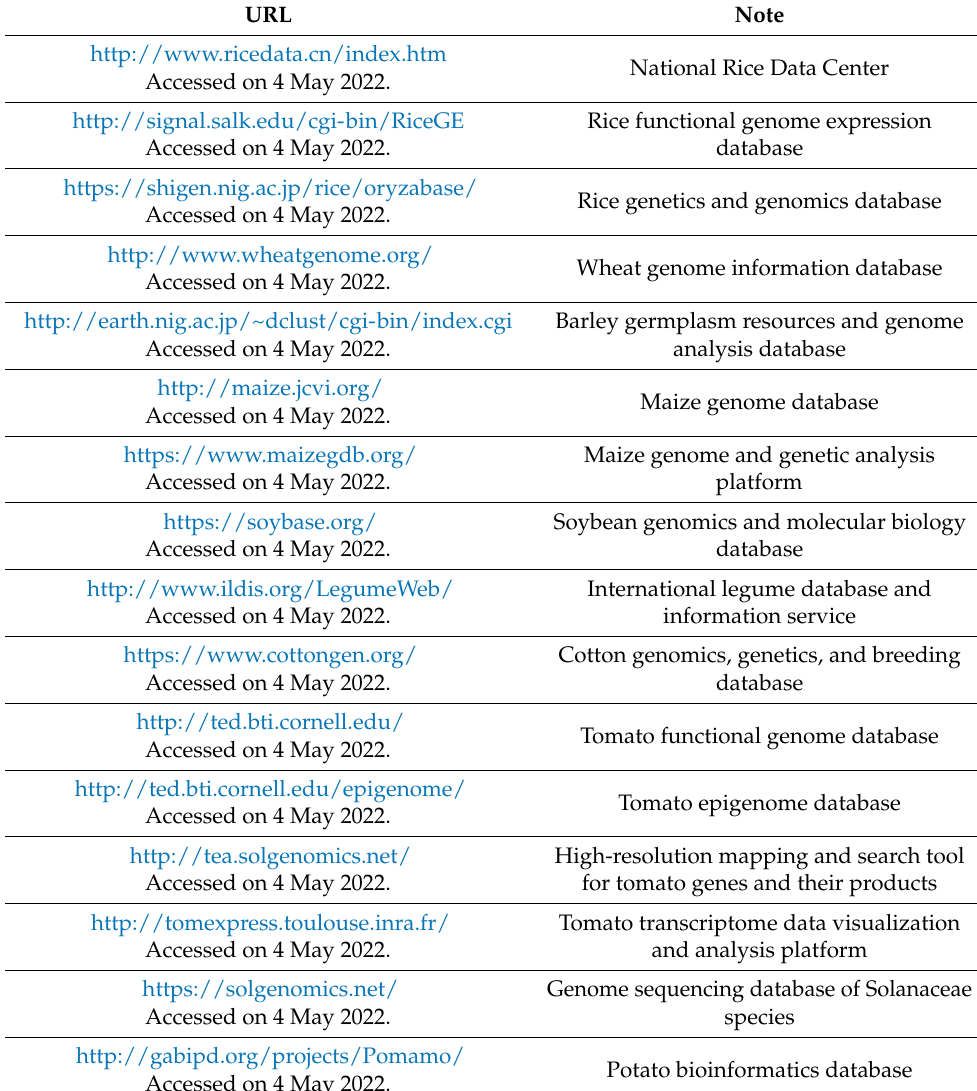
Table 3. Databases used for major